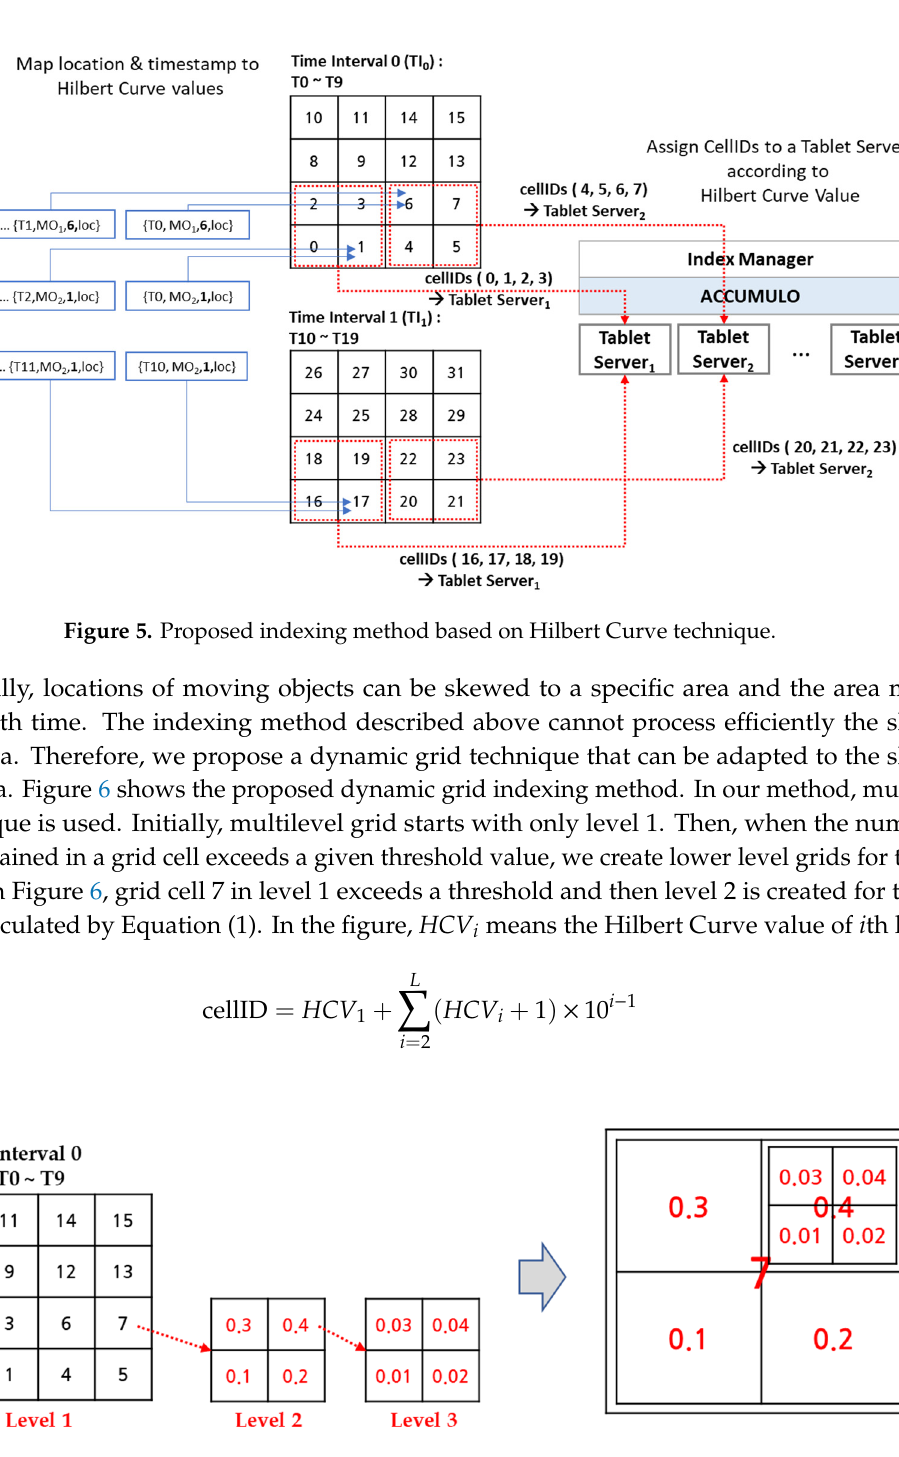
Figure 7. Example of dynamic grid indexing. In the above example, cellIDs are assigned to the data records like Table 1. As shown in the table, data records inserted before a new level of grid is created have cellIDs assigned to it. Consequently, all levels of cellIDs must be considered to process a range query. In Figure 8, we show an example to process range queries. Figure 8a shows an example of range query processing on one level grid. Range queries Q1 and Q2 overlap the grid cell 7 so to process the queries we need to compare all data records in the cell. In Figure 8b, range queries are processed on dynamic multilevel grid indexing method. In this example, to process Q1 and Q2, retrieve 4 records and 6 records only, respectively.